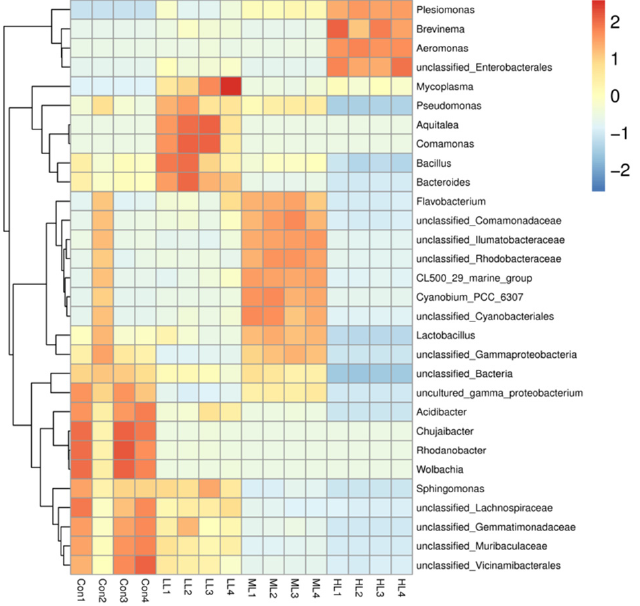
Figure 3. The heat map of intestinal microbiota of largemouth bass fed with four experimental diets. Con means control diet. LL, ML, and HL mean 5 g Kg − 1 , 10 g Kg − 1 and 15 g Kg − 1 laminarin was supplemented into diets, respectively.